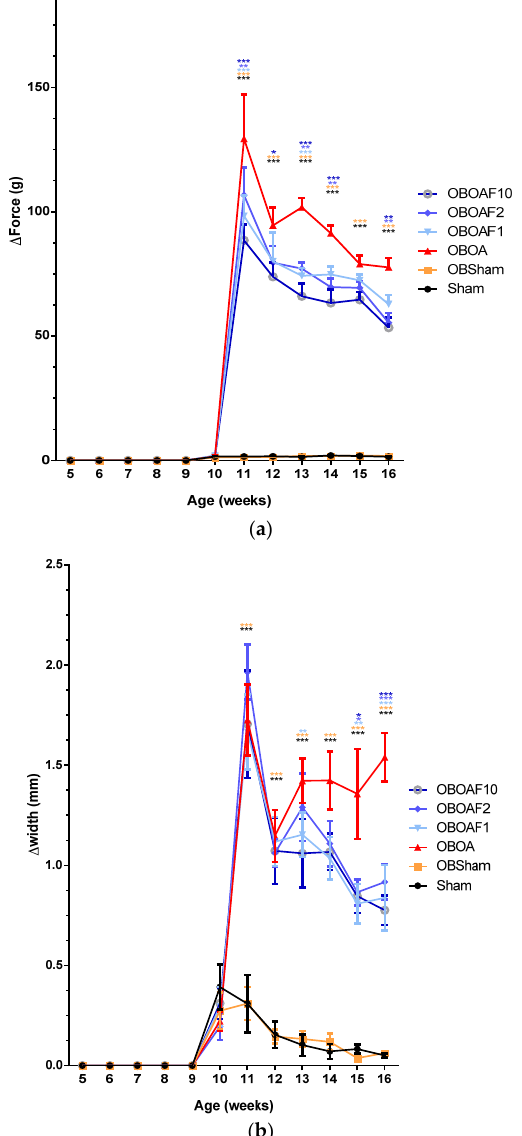
Figure 6. The effect of fucoidan treatment in HFD-induced obese male rats with ACLT + MMx surgery induced OA. ( a ) The on the weight-bearing distribution of the hind limbs. ( b ) The knee joint width. The data are the difference between the weights applied to the contralateral and ipsilateral limbs, expressed as the mean ± S.E.M. A two-way ANOVA and Dunnett’s multiple comparisons test were used to analyze the data. * p < 0.05, ** p < 0.01, *** p < 0.001, when compared to the OA